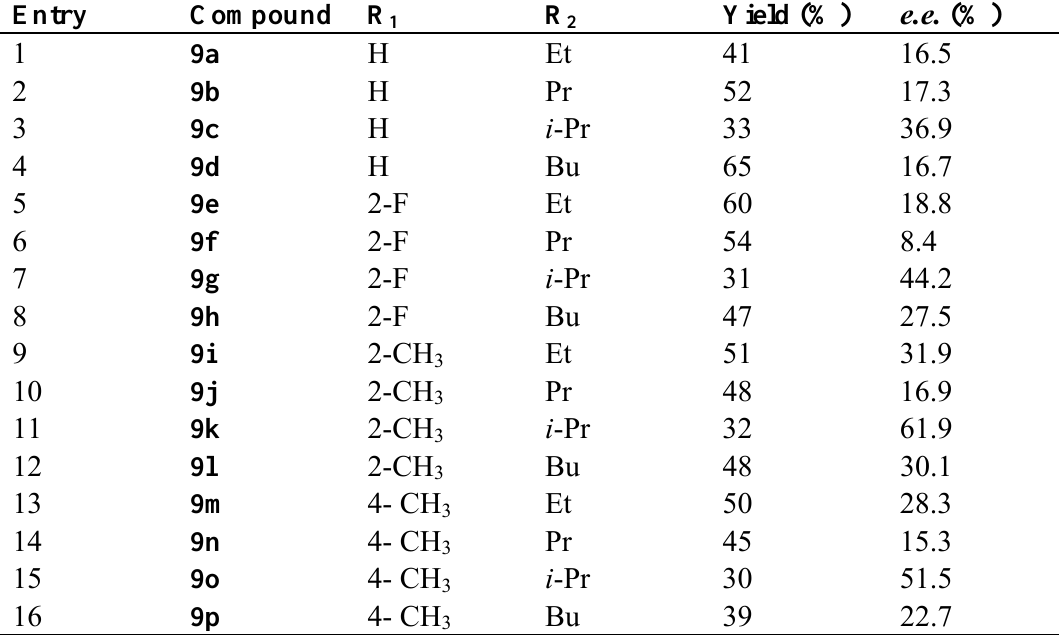
Table 3. Organocatalytic enantioselective reaction with chiral phosphoric acid 6a .